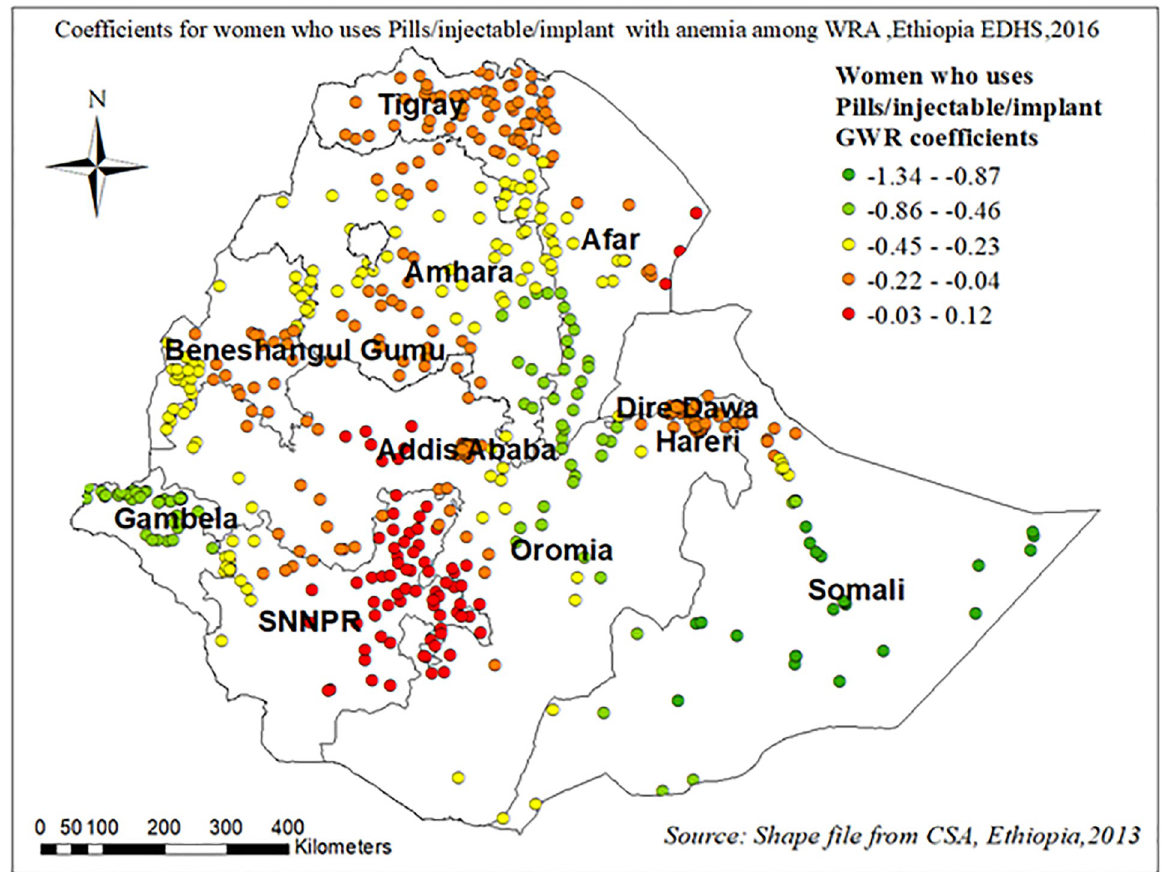
Fig 12. Coefficients for women who use pills, injectable contraceptives, and implants with anemia among reproductive-age women in Ethiopia, EDHS 2016.